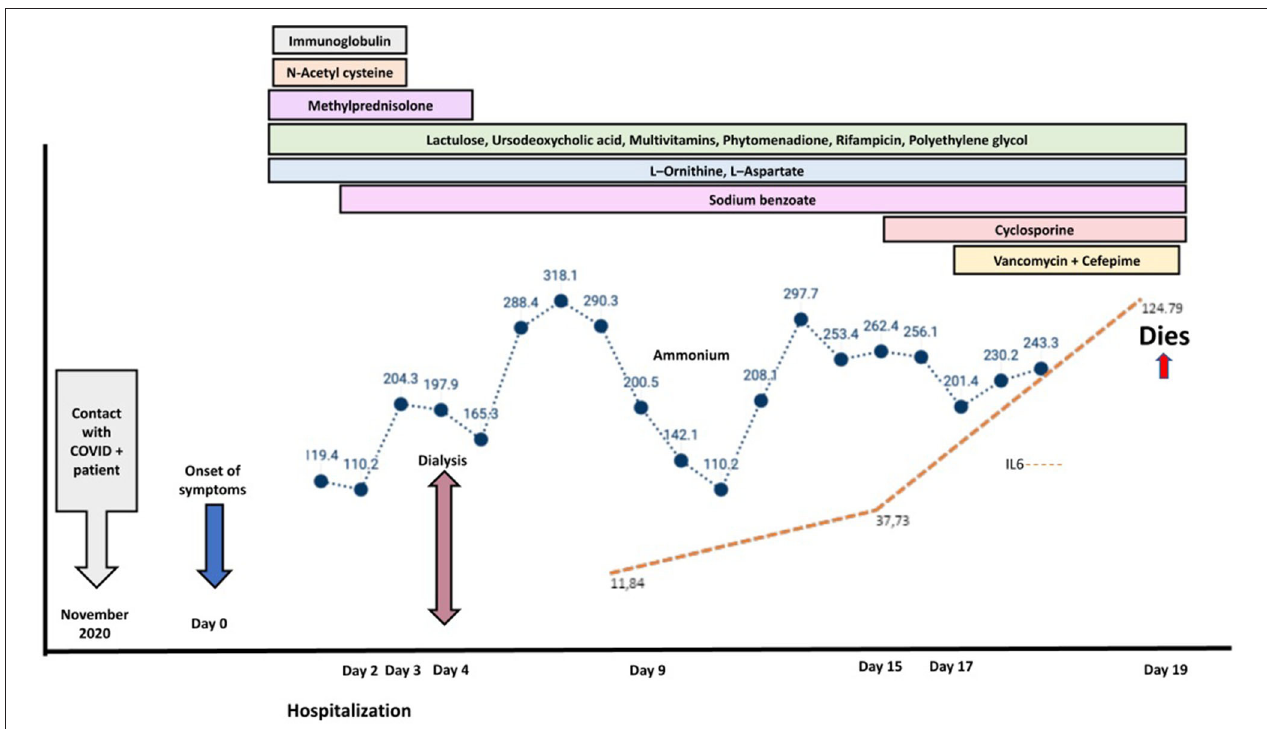
FIGURE 1 | Natural history of the patient’s disease. The image corresponds to the evolution of increasing ammonium (blue line) and IL-6 (orange line) values until the fatal outcome. The color bars correspond to the treatment strategies applied in the clinical course of the patient.